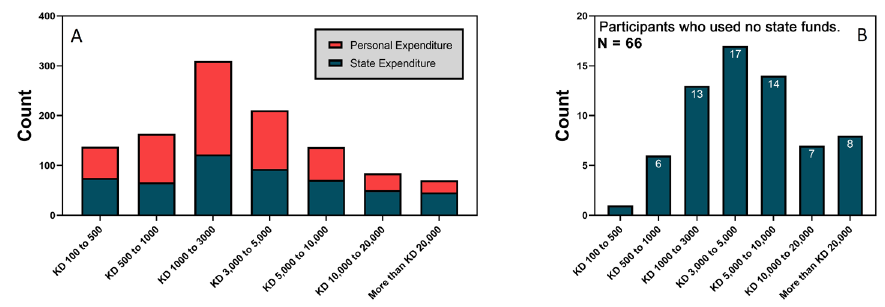
Figure 6. State and Personal Expenditures During Medical Treatment Abroad. (A) Participants who covered their expenses by state and personal funds; (B) Participants who went abroad solely on their personal